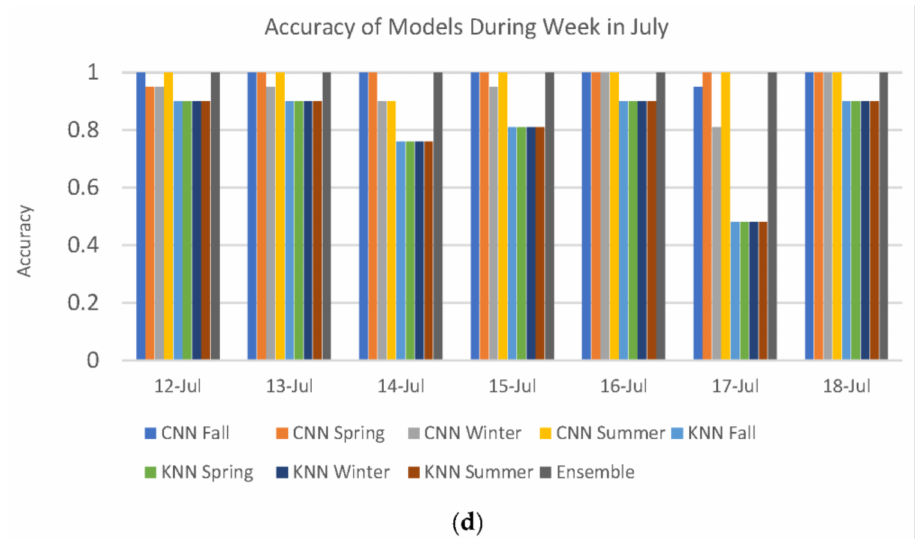
Figure 7. Model accuracies during various seasons: ( a ) model accuracies during a week of October using all models; ( b ) model accuracies during a week of May using all models; ( c ) model accuracies during a week of January using all models; ( d ) model accuracies during a week of July using all